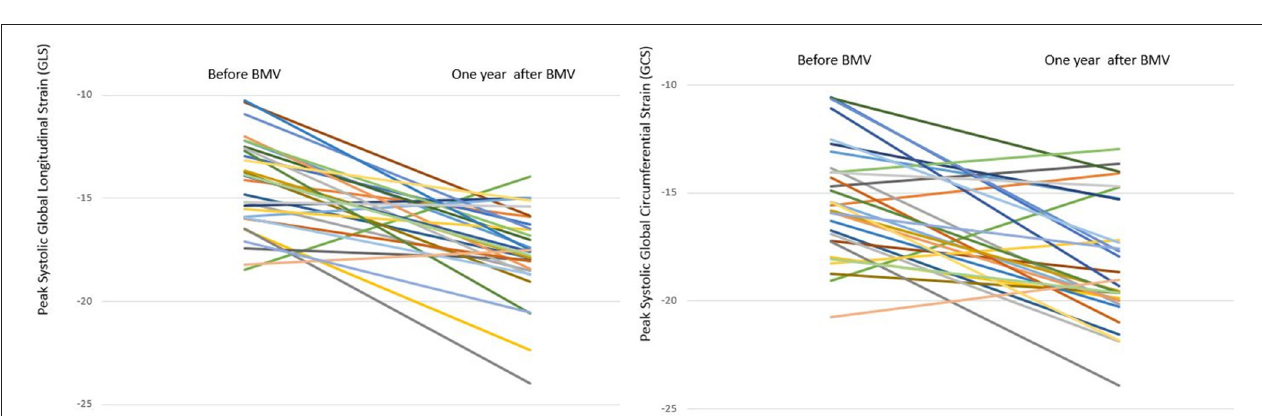
FIGURE 4 | Bar graphs showing Changes in LV GLS after BMV (A) and Changes in LV GCS after BMV (B) .